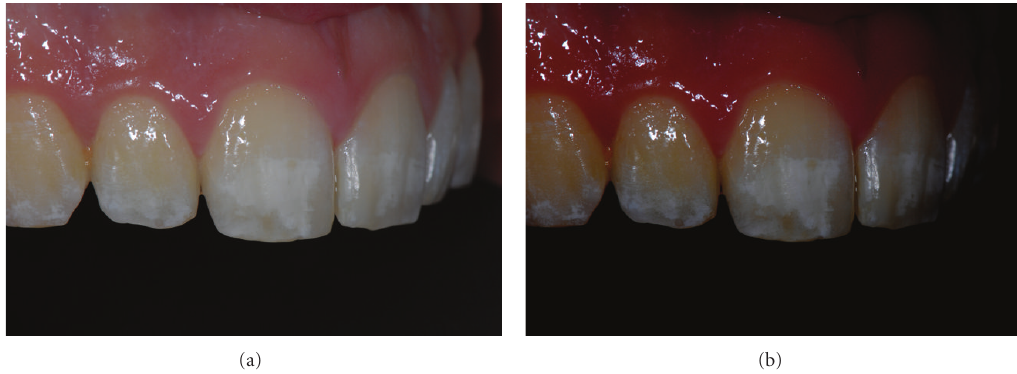
Figure 2: (a) Initial right side picture. (b) Software-modified initial right side